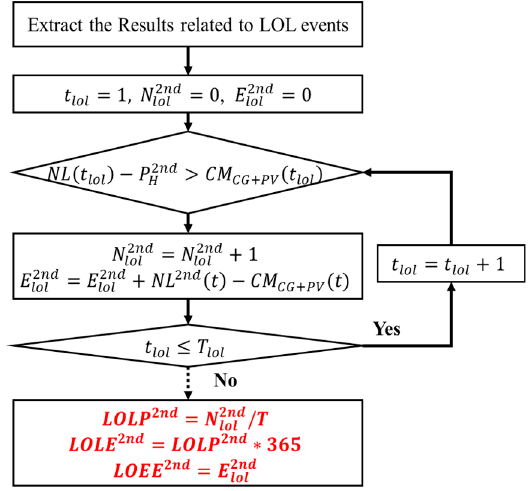
Figure 7. Flow Chart of Reliability Evaluation at the Second